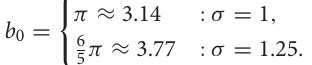
Algorithm 4.1 (Shape parameter tuning).